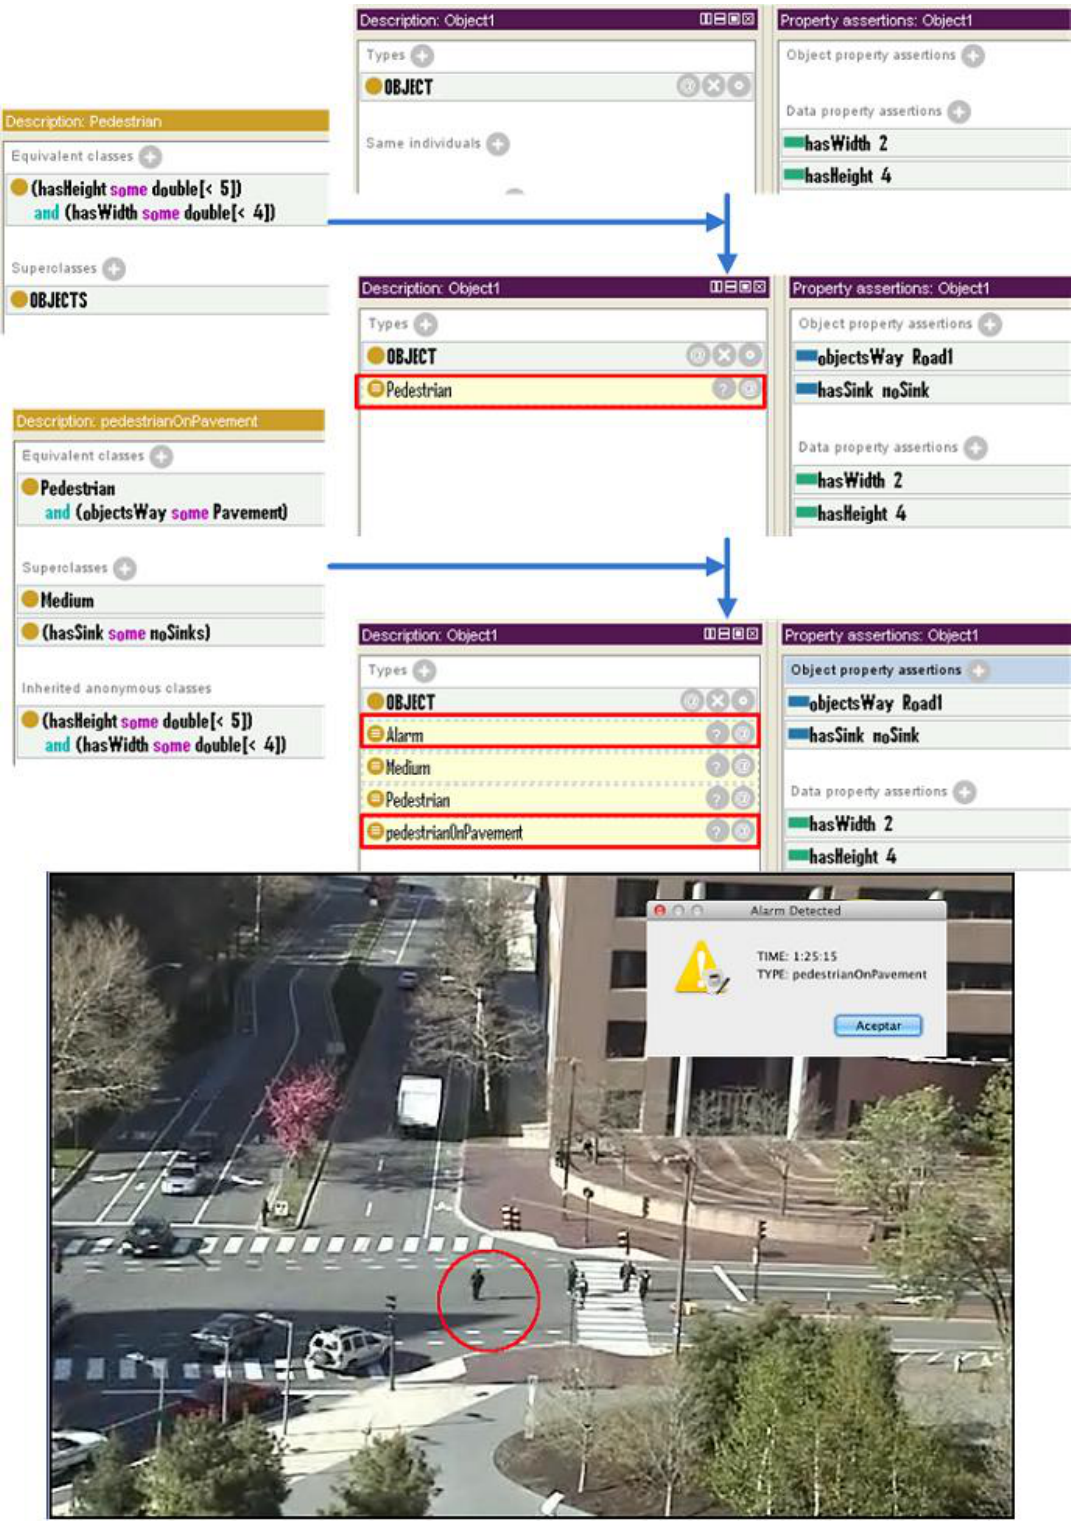
Figure 7. Example of semantic reasoning for pedestrian use